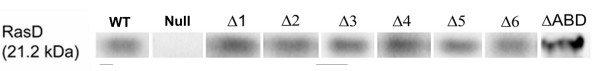
RasD binding does not depend on any single repeat in the rod domain nor the actin binding domain. Western blot using the antiRasD antibody to detect RasD in immunoprecipitations using protein extract from HPF616 (lane 1, WT) (AX2 ectopically expressing RasD), HPF631 (lane 2, Null) (HG1264 ectopically expressing RasD) and strains HPF632-638 (lanes 3–10) (HG1264 ectopically expressing RasD and one of filaminΔ1–6 or filaminΔABD as indicated). RasD is detected in all IP samples with the exception of the null mutant HPF631, indicating that filamin is required to pull down RasD and RasD interacts with filamin regardless of which portion of the scaffolding protein is absent.